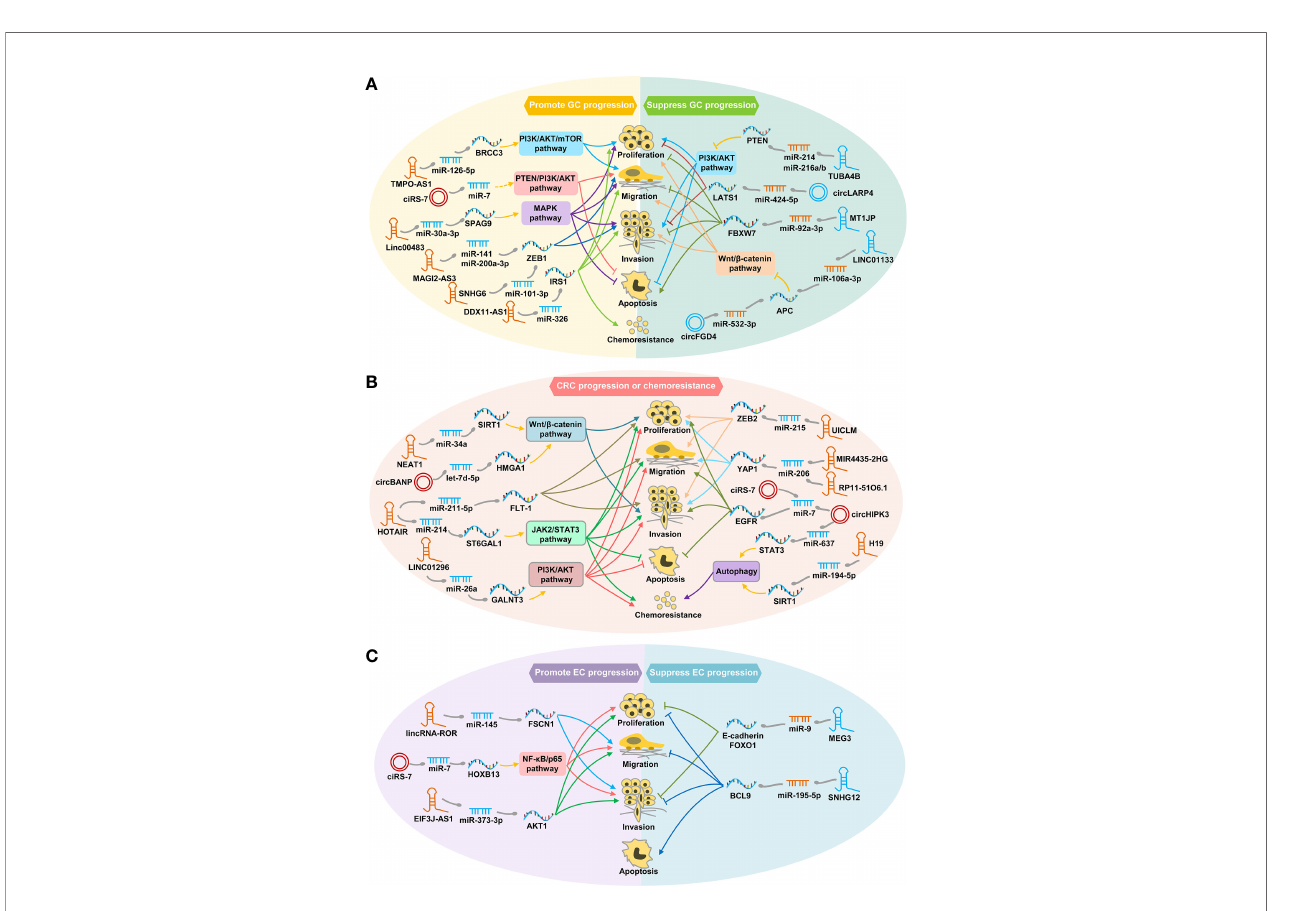
FIGURE 1 | Schematic diagram of representative ceRNA crosstalks function in GC (A) , CRC (B) and EC (C) . (A) ceRNA interaction regulates tumor cell proliferation, migration, invasion, apoptosis, or chemoresistance through PI3K/ATK, MAPK or Wnt/ b -catenin signaling pathways, thereby exerting carcinogenic or tumor suppressor effects in GC. (B) ceRNA interaction contributes to CRC progression or chemoresistance by regulating autophagy process or pivotal pathways, such as Wnt/ b -catenin, PI3K/ATK and JAK2/STAT3 signaling pathway. (C) ceRNA interaction promotes or inhibits EC progression by modulating cancer cell proliferation, migration, invasion, or